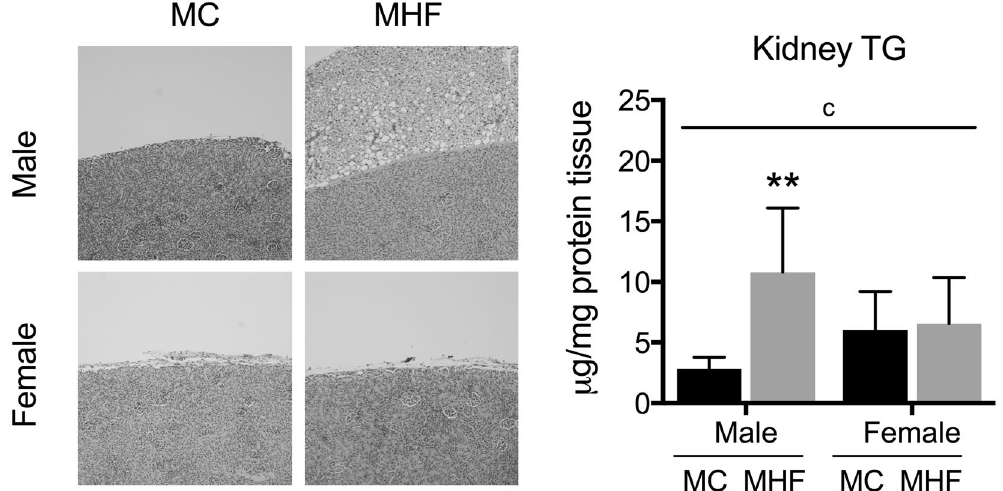
Figure 1. Maternal high-fat diet increases perirenal fat deposition and triglyceride concentration in male but not female offspring. MC (offspring of dams fed chow); MHF (offspring of dams fed high-fat diet). Results are expressed as mean ± SD. Data were analysed by two-way ANOVA followed by Bonferroni post hoc test. ( a ) (P < 0.05, Maternal diet effect), ( b ) (P < 0.5, Sex effect), ( c ) (P < 0.05, interaction effect), ** P < 0.01 (vs MC offspring). n =